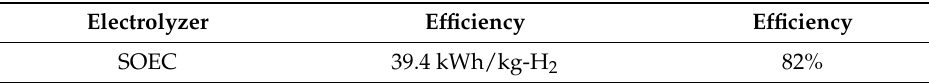
Table 2. Electrolyzer efficiencies [43].